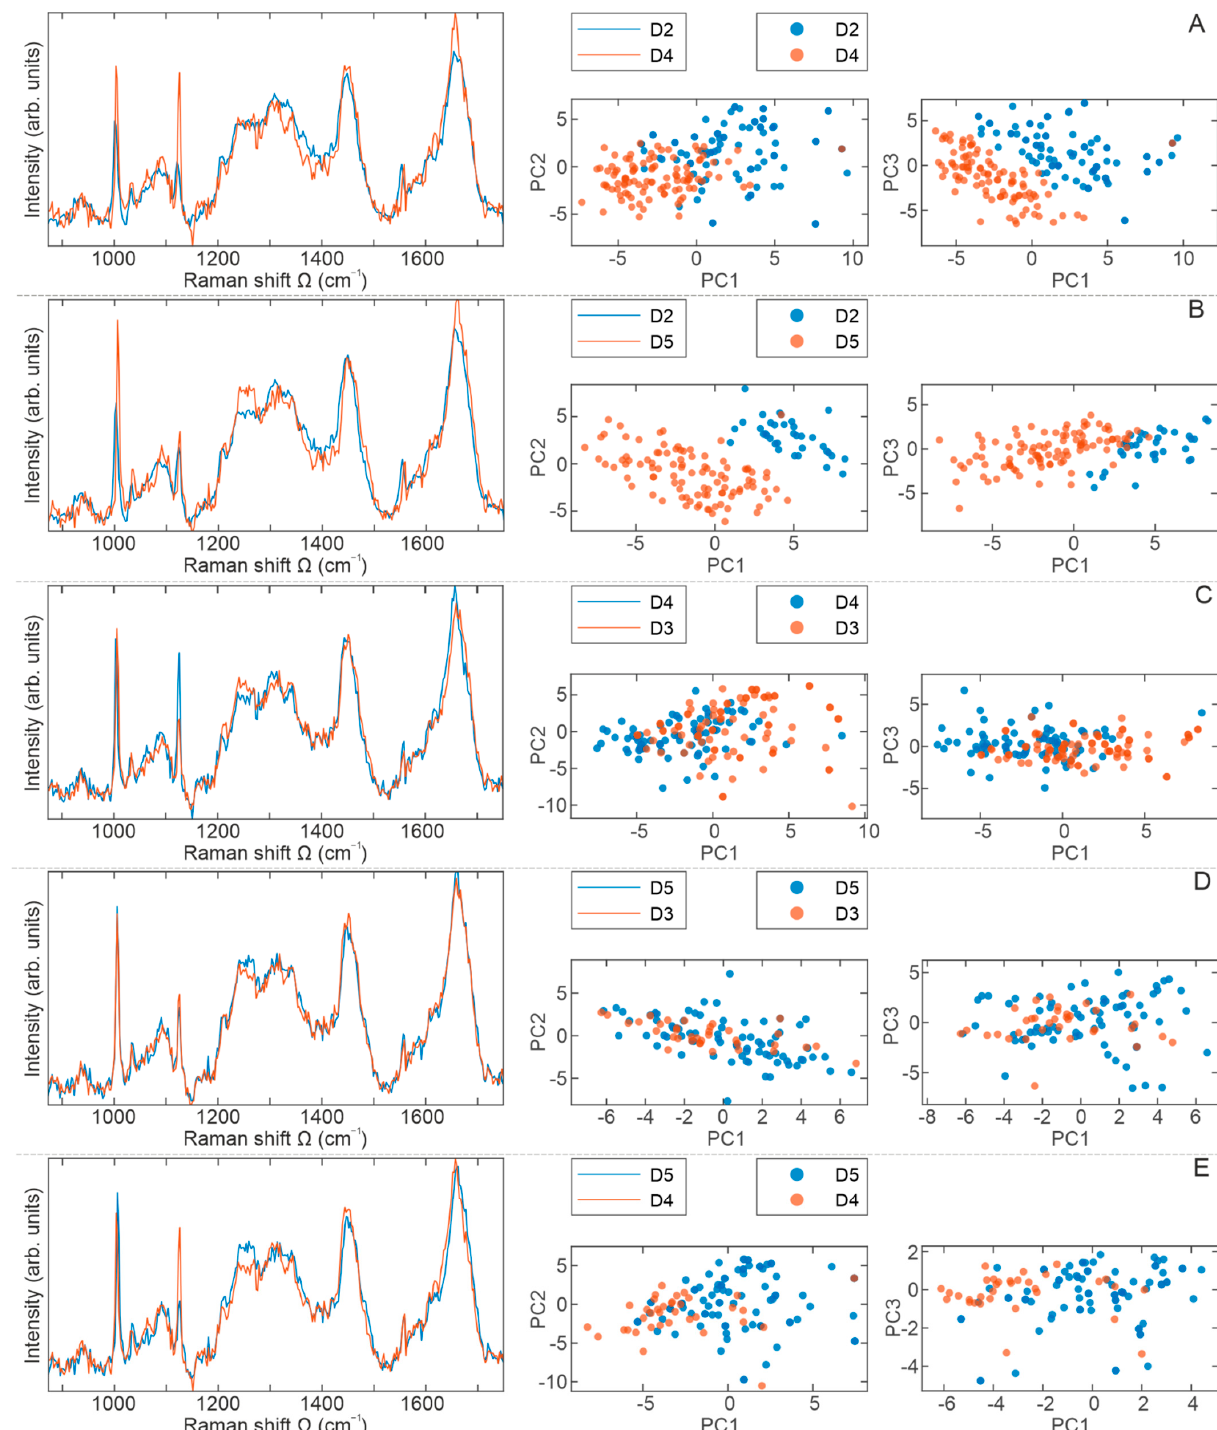
Figure 7. Comparative representation of BM-MSCs Raman spectra presented in pairs. BM-MSCs were seeded on rounded CaF2 slides (Raman grade quality) and cultivated under standard conditions for 24 h. Prior Raman scattering experiments cells were washed with saline buffer and fixed with methanol for 10 min at the room temperature. On average, 50 to 100 cells per each cell population were analyzed. A comparative display of the averaged Raman spectra (red and blue lines) per cell populations: ( A ) D2–D4, ( B ) D2–D5, ( C ) D3–D4, ( D ) D3–D5, and ( E ) D4–D5. PCA score plots are represented with red and blue